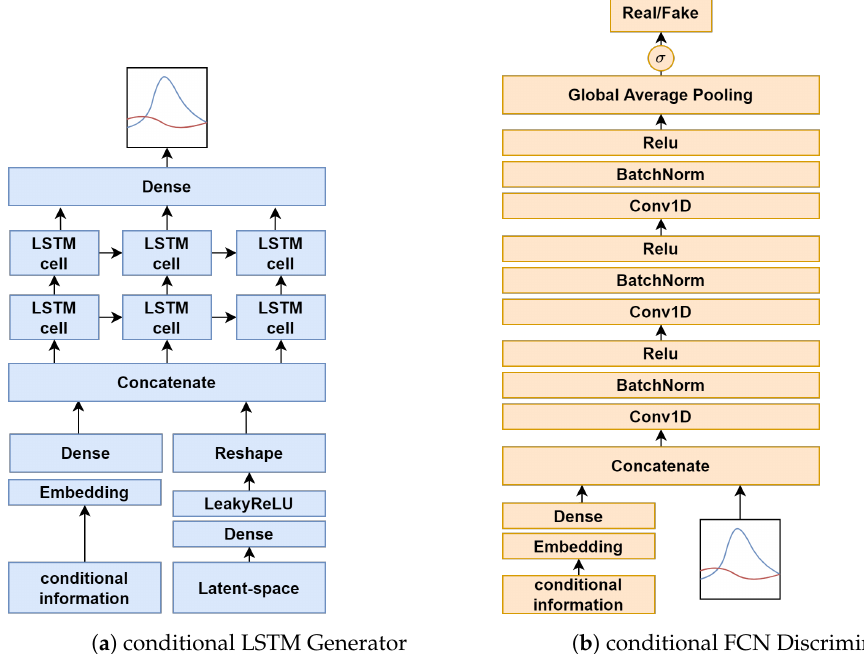
Figure 5. The architecture of our conditional GAN. In the input and output figure in ( a , b ), the blue line indicates GSR and the red line indicates ST, which shows a prototypical